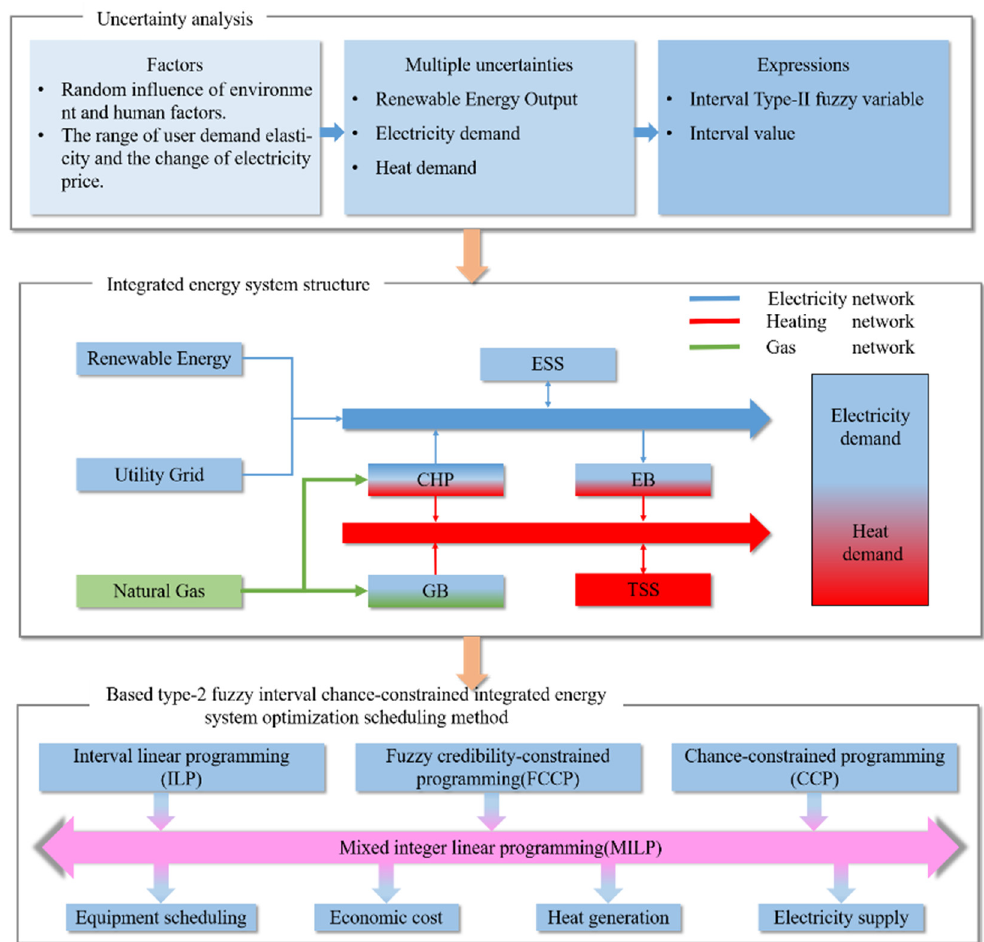
Figure 2. Optimal scheduling framework of IES based on T2FICCP.